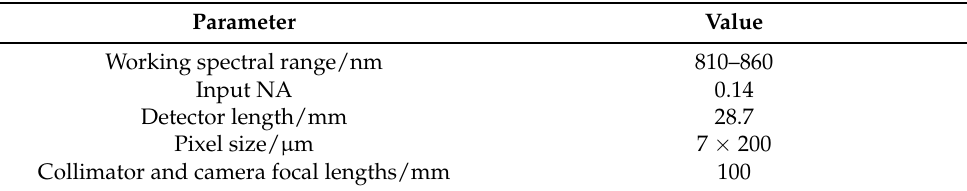
Table 1. Initial values for the spectrographs designs.